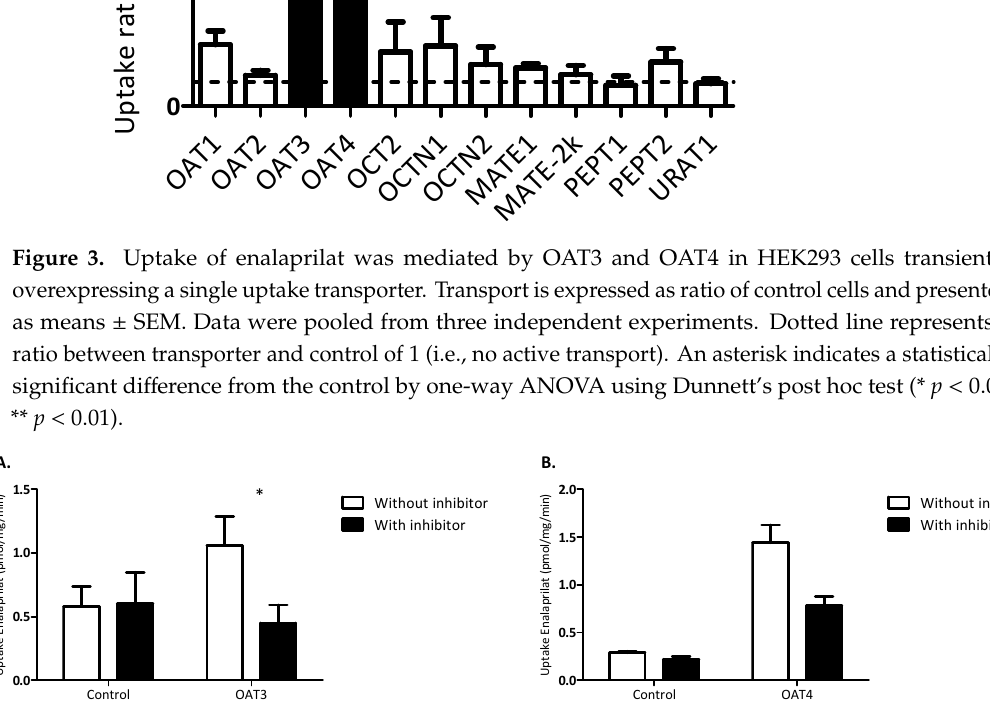
Figure 5. Concentration-dependent uptake of enalaprilat by OAT3 and OAT4. Michaelis–Menten kinetic curves showing the relationship between enalaprilat concentration and transport velocity of OAT3 and OAT4. For OAT3, a Km value of 640 µM (95% CI 510–770 µM) was observed, whereas saturation of transport via OAT4 was not reached over the concentration range measured. Transport velocity is expressed in percentage of maximum velocity and presented as mean ± SEM for each data point. Data were pooled from three independent experiments. Inhibitory potency of enalaprilat against OAT3. Transport of [ 3 H]-E1S by OAT3 was determined in the presence of increasing enalaprilat concentrations. Exposure to enalaprilat concentration- dependently inhibited the uptake of 3 H-E1S with a K i value of 134 µM (Supplementary Figure S2). Specificity for MRP2, MRP4, P-gp, and BCRP. For the efflux transporters MRP2, MRP4, BCRP, and P-gp, of which MRP4 has been described previously as relevant for hepatic efflux of enalaprilat into the systemic circulation, we tested the specificity of these transporters for enalaprilat in order to understand apical transport [14]. Using both a vesicular assay as well as a double-transduction